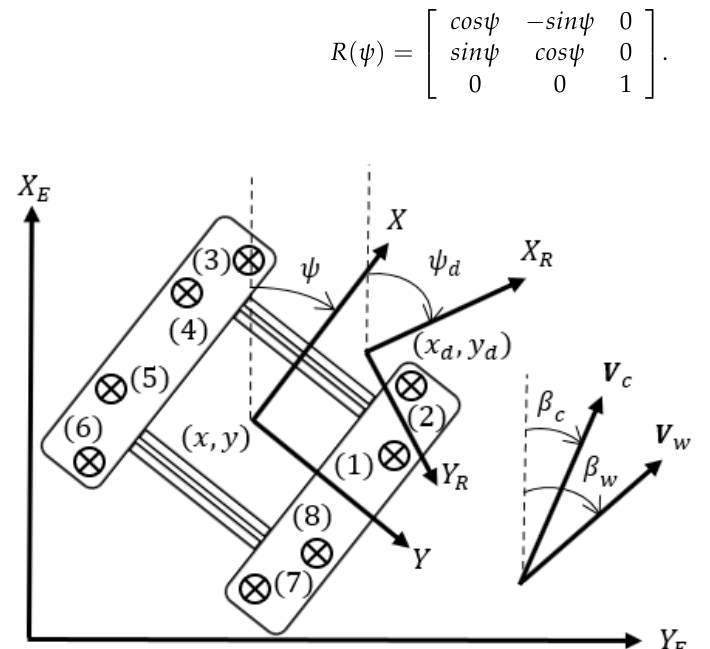
Figure 2. Semisubmersible platform kinematics and thrusters’ locations.